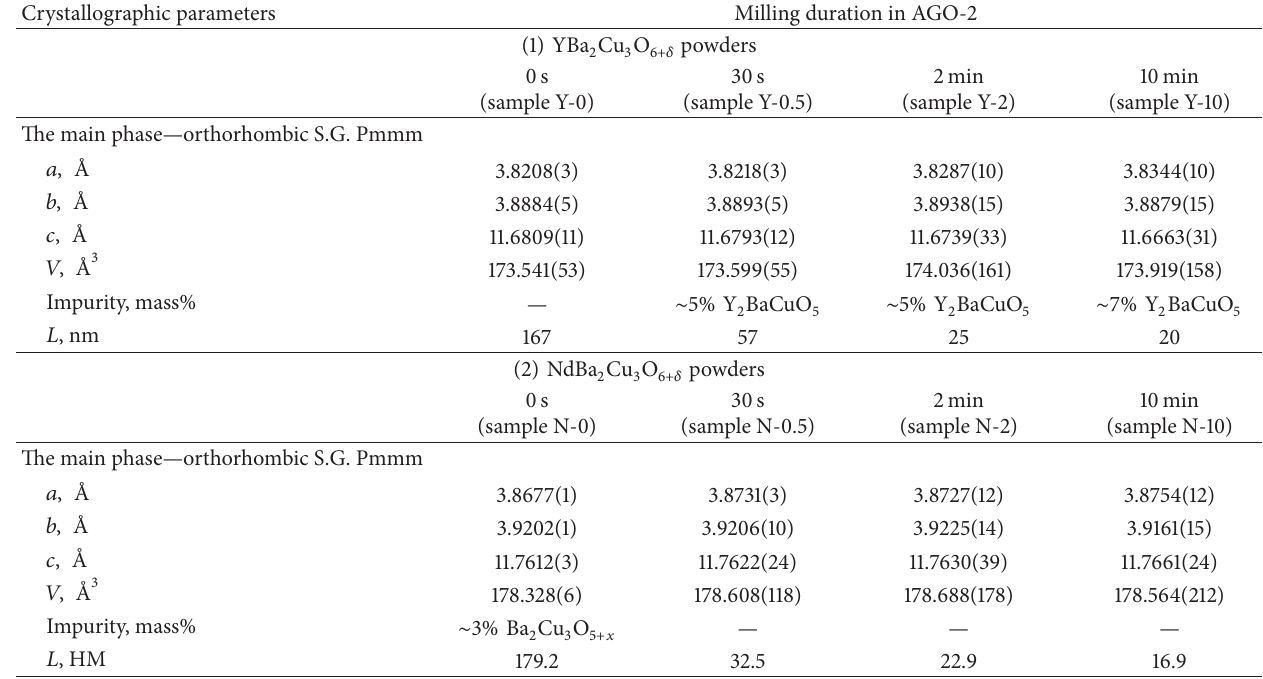
Table 1: Phase composition, lattice parameters, and the size of coherent scattering regions ( 𝐿 ) for YBa 2 Cu 3 O 6+𝛿 and NdBa 2 Cu 3 O 6+𝛿 before and after mechanical treatment.